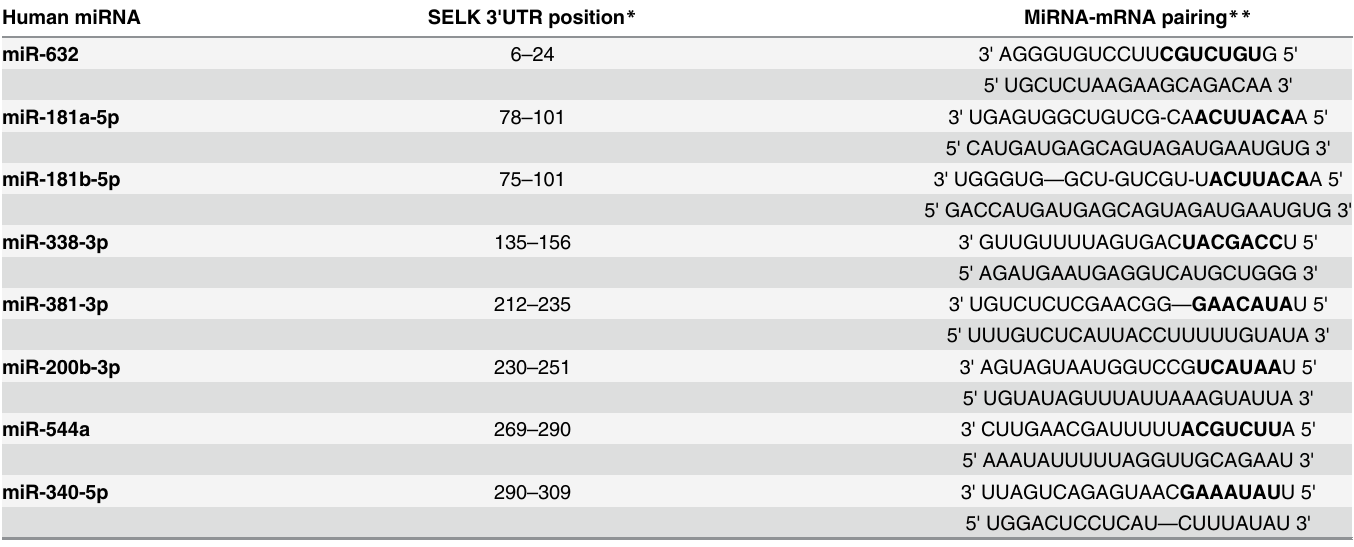
Table 1. Human microRNAs with potential binding sites on SELK 3 ’ UTR. Human